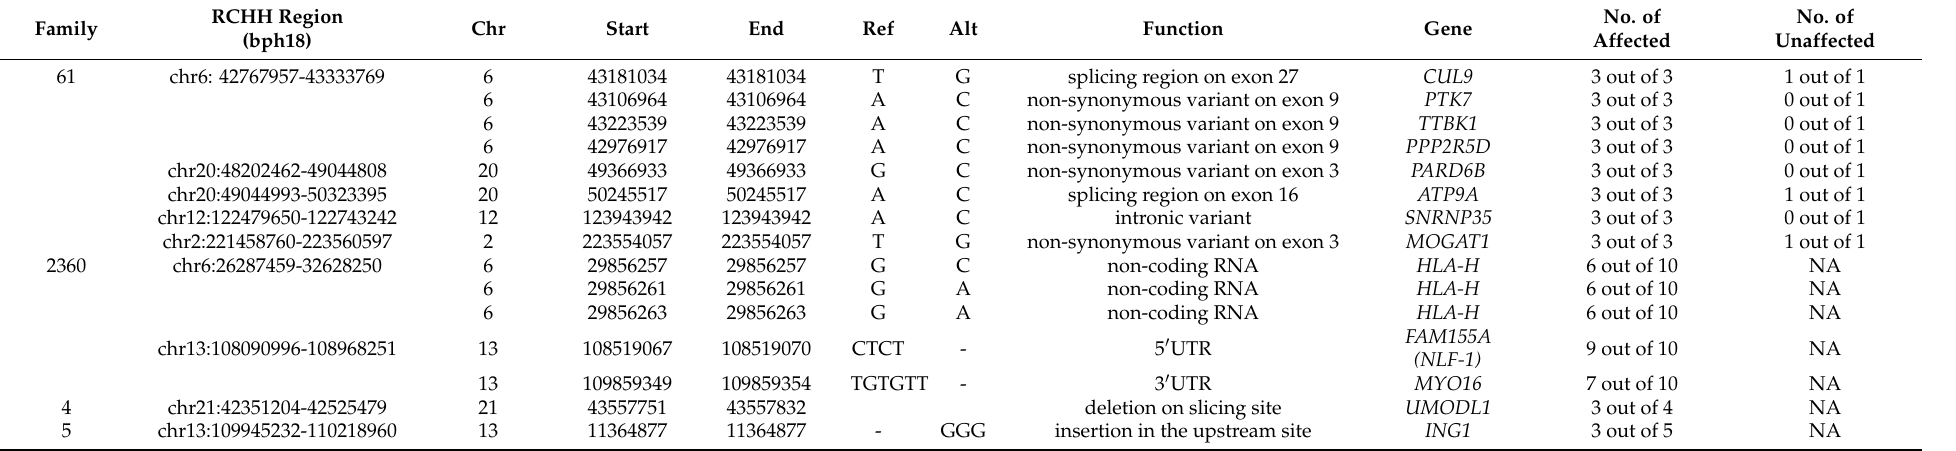
Table 3. Results of WES analysis. For each family and for each RCHH region, identified by HH analysis, the variant, its function, and the number of cases and controls sharing the variant are